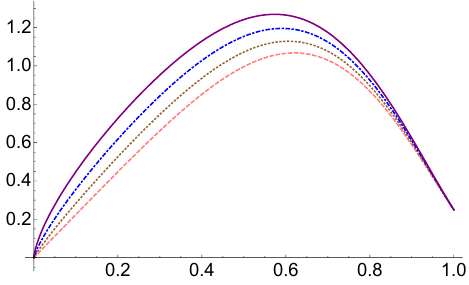
Figure 3. f ( x ) with q = α , where q = 0.7 (dashed), q = 0.8 (dotted), q = 0.9 (dashed-dotted), and exact solution q = 1 (continuous), for Example